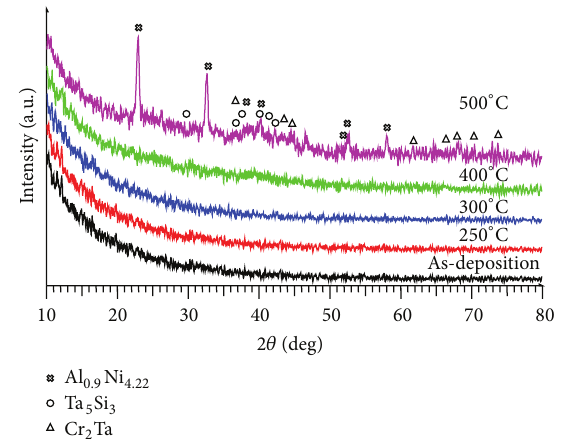
Figure 2: X-ray diffraction patterns of Ni-Cr-Si-Al-Ta thin films sputtered at 200 W with different annealing